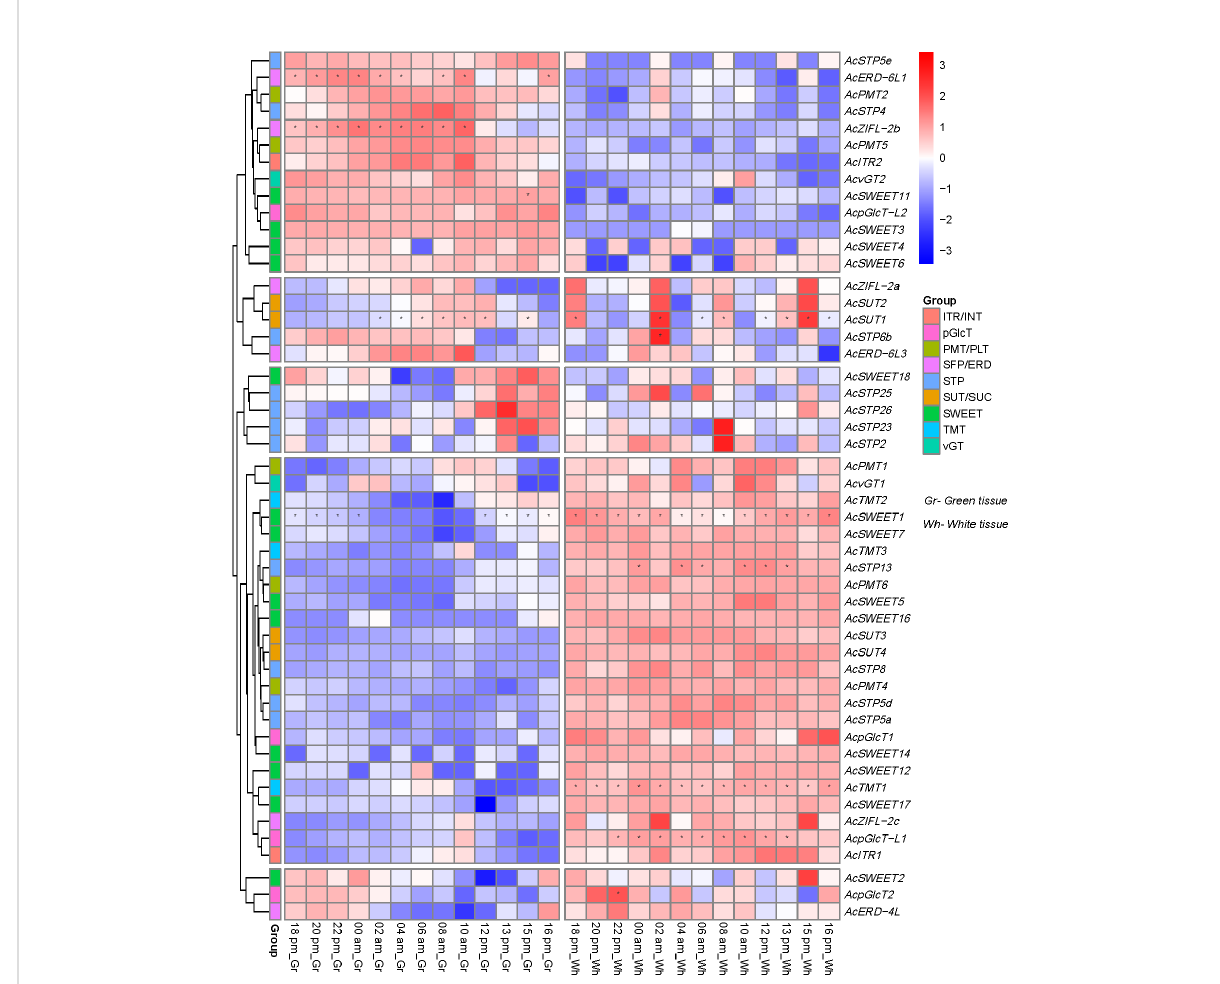
FIGURE 8 Expression pattern and pineapple sugar transporter genes across circadian rhythm in green (photosynthetic, left panel) tissue at the leaf tip and white (non-photosynthetic, right panel) tissue. The heatmap was created based on the log2 (TPM + 0.01) value of the genes and normalized by row. Red color represents a high transcript abundance, and blue represents low transcript abundance, and asterisks (*) represent the FKM values above